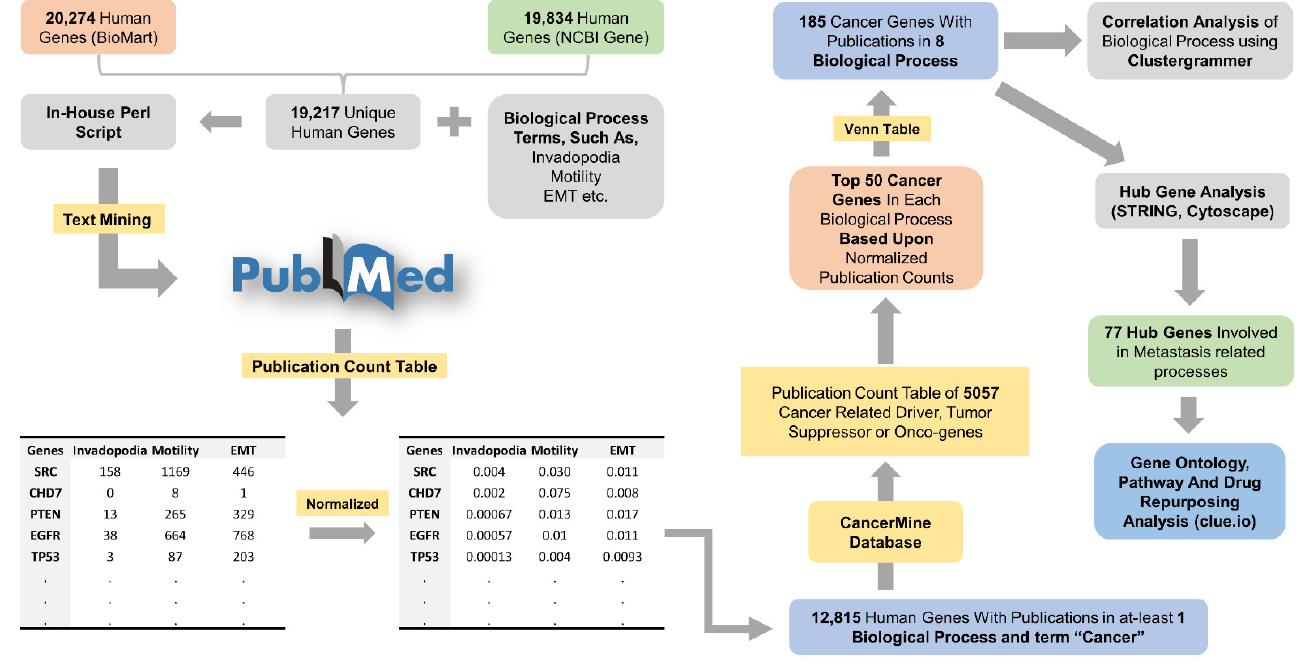
Figure 1. The framework of text-mining and bioinformatics analysis to study cancer metastasis-related genes.